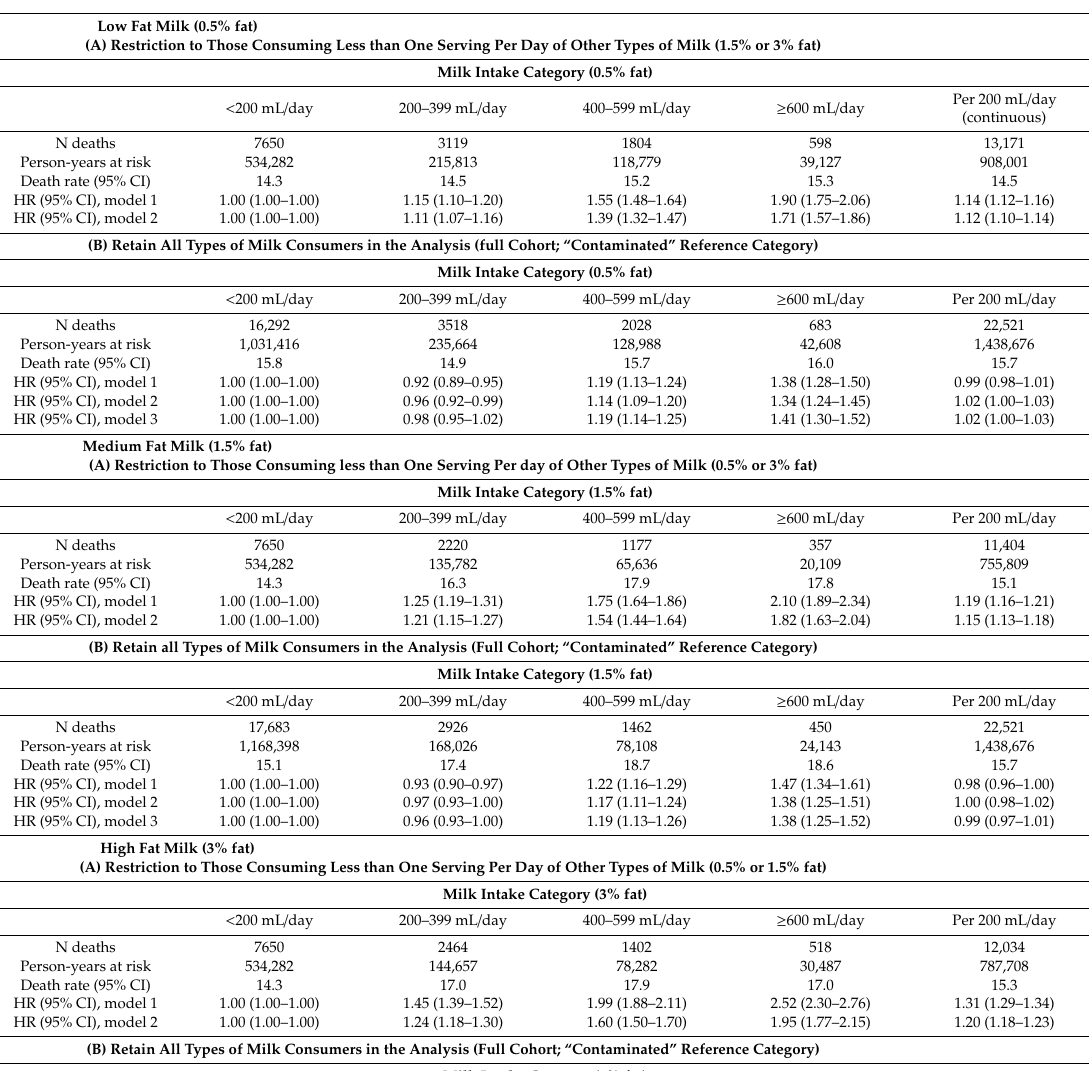
Table 2. Hazard ratios (HRs) and 95% confidence intervals (CI) of total mortality, according to consumption of type of non-fermented milk in women from the Swedish Mammography Cohort with the exposure time-updated as cumulative